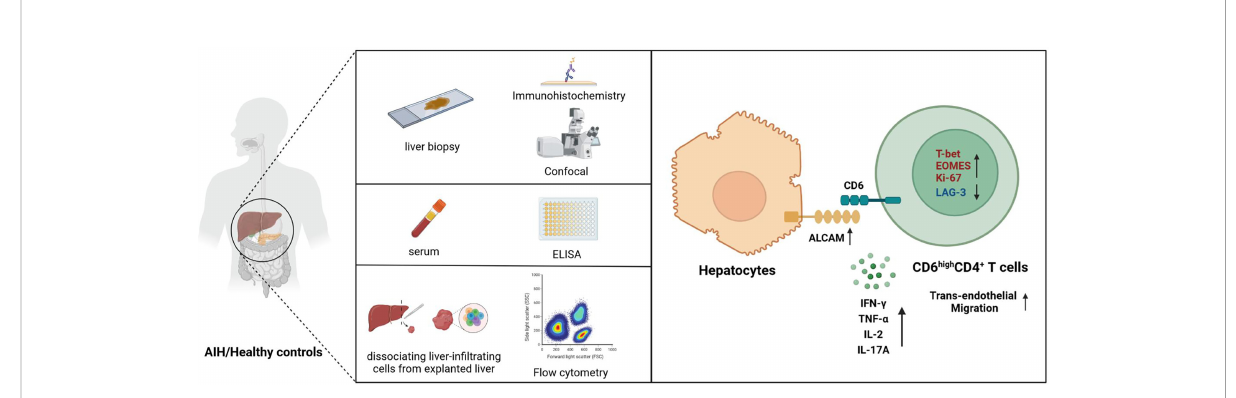
FIGURE 6 Schematic diagram for this study. Upregulated ALCAM on hepatocytes promoted the trans-endothelial migration of pathogenic CD6 high CD4 + T cells, which further aggravated hepatic in fl ammation of patients with AIH. This study revealed a putative therapeutic approach for patients with